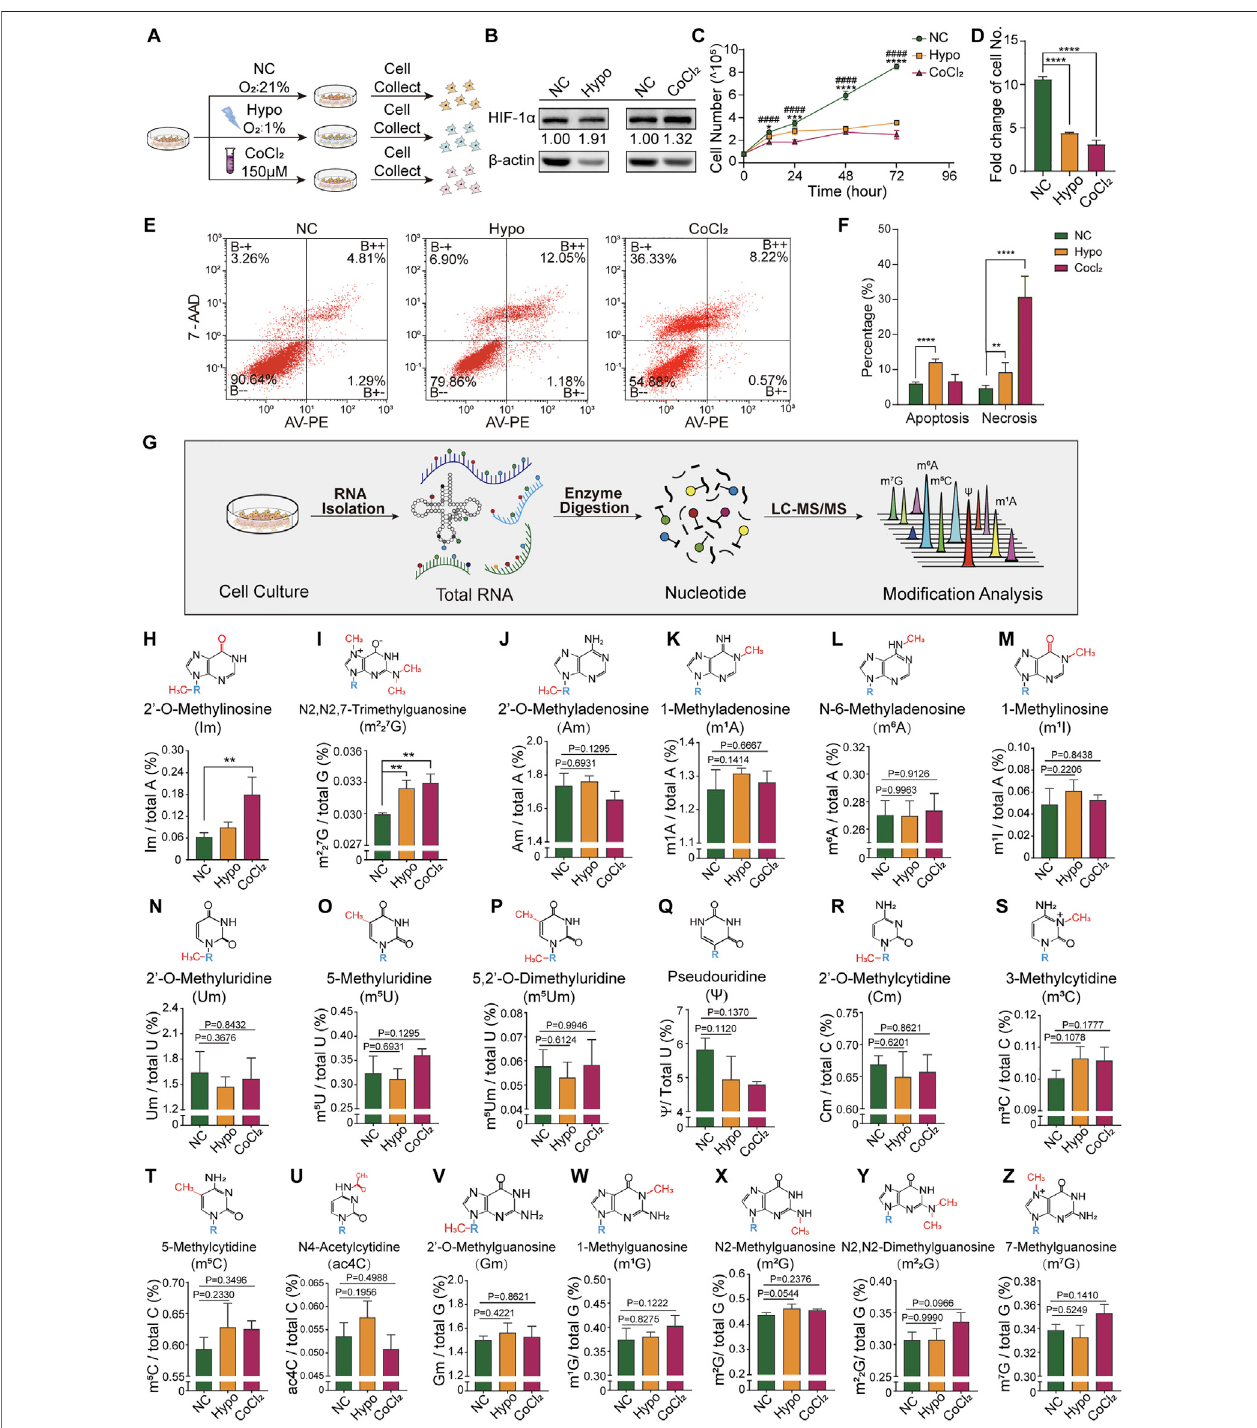
FIGURE 1 | Cellular response and alterations in RNA modi fi cation signatures in GC-2spd cells subjected to hypoxic stress. (A) Schematic illustration of GC-2spd cell hypoxia treatment either by hypoxic culture (Oxygen Conc. 1%) for 48 h or normoxic culture in the presence of 150 μ M CoCl 2 for 24 h. (B) Western blot analysis of HIF-1 α protein expression in GC-2spd cells exposed to hypoxia or CoCl 2 . (C) GC-2spd cell proliferation at 0, 12, 24, 48, and 72 h under normoxic, hypoxic, and CoCl 2 treatmentconditions. (D) GC-2spdcellgrowthrateat72 h. (E) FlowcytometricanalysisofapoptosisinGC-2spdcellssubjectedtohypoxiaorCoCl 2 treatment. (F) Statistical analysis of cell apoptosis and non-apoptotic cell death rates in GC-2spd cells. (G) Illustration of the detection of total RNA modi fi cations in GC-2spd cells by LC-MS/MS. (H – Z) Relative levels of representative Im, m 2 27 G, Am, m 1 A, m 6 A, m 1 I, Um, m 5 U, m 5 Um, ψ , Cm, m 3 C, m 5 C, ac4C, Gm, m 1 G, m 2 G, m 2 2 G, and m 7 G RNA modi fi cations in GC-2spd cells subjected to hypoxia or CoCl 2 treatment. Statistical analysis was performed by one-way analysis of variance (ANOVA), two-way ANOVA multiple comparisons, and Sidak ’ s or Dunnett ’ s multiple comparisons test. * p < 0.05, ** p < 0.01, *** p < 0.001, **** p < 0.0001, #### p < 0.0001 compared to NC. n = 3. Data in C, D, F, and H-Z are presented as mean ±